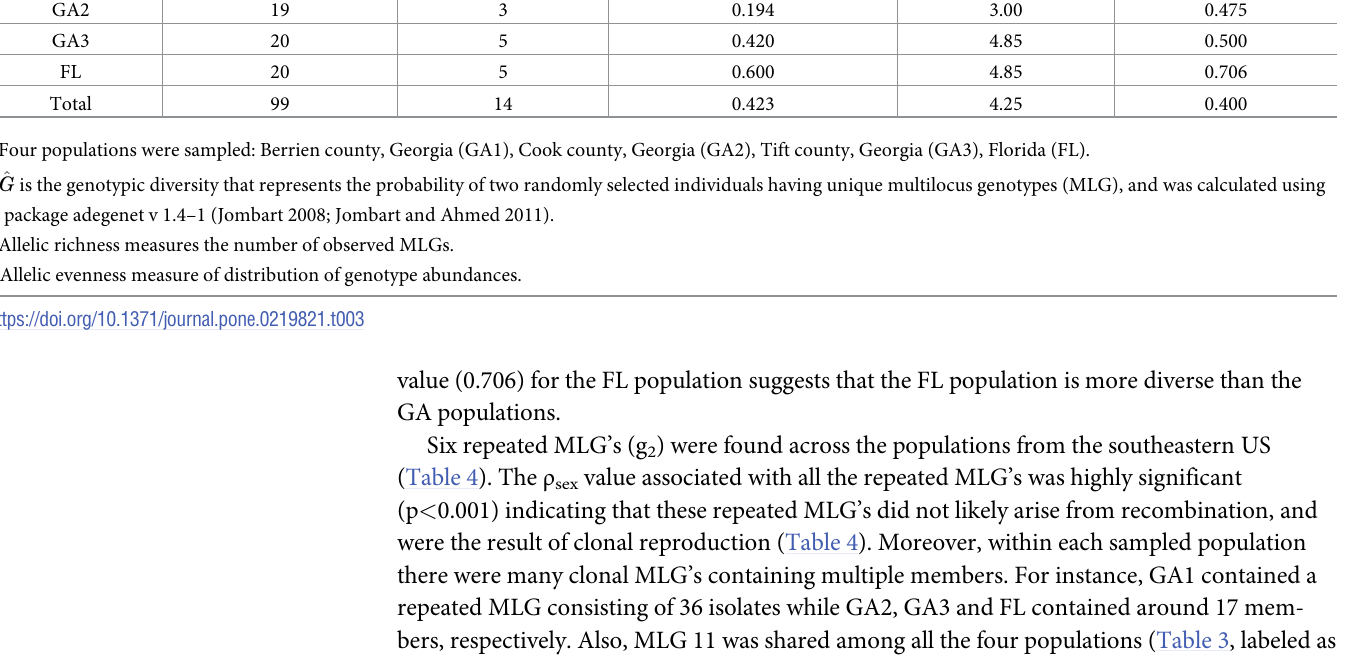
Population structure of Fusarium oxysporum f. sp. Niveum Pairwise population differentiation ( Ф ) was performed on the four populations. Significant PT differences were observed between the FL population and GA1, GA2, GA3 populations